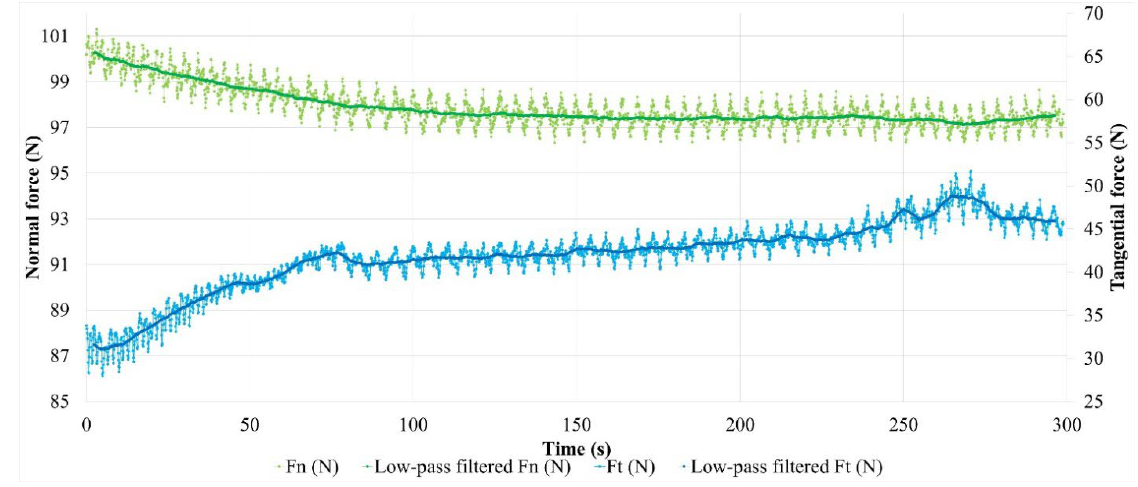
Figure 12. Evolution of contact forces for material M1.